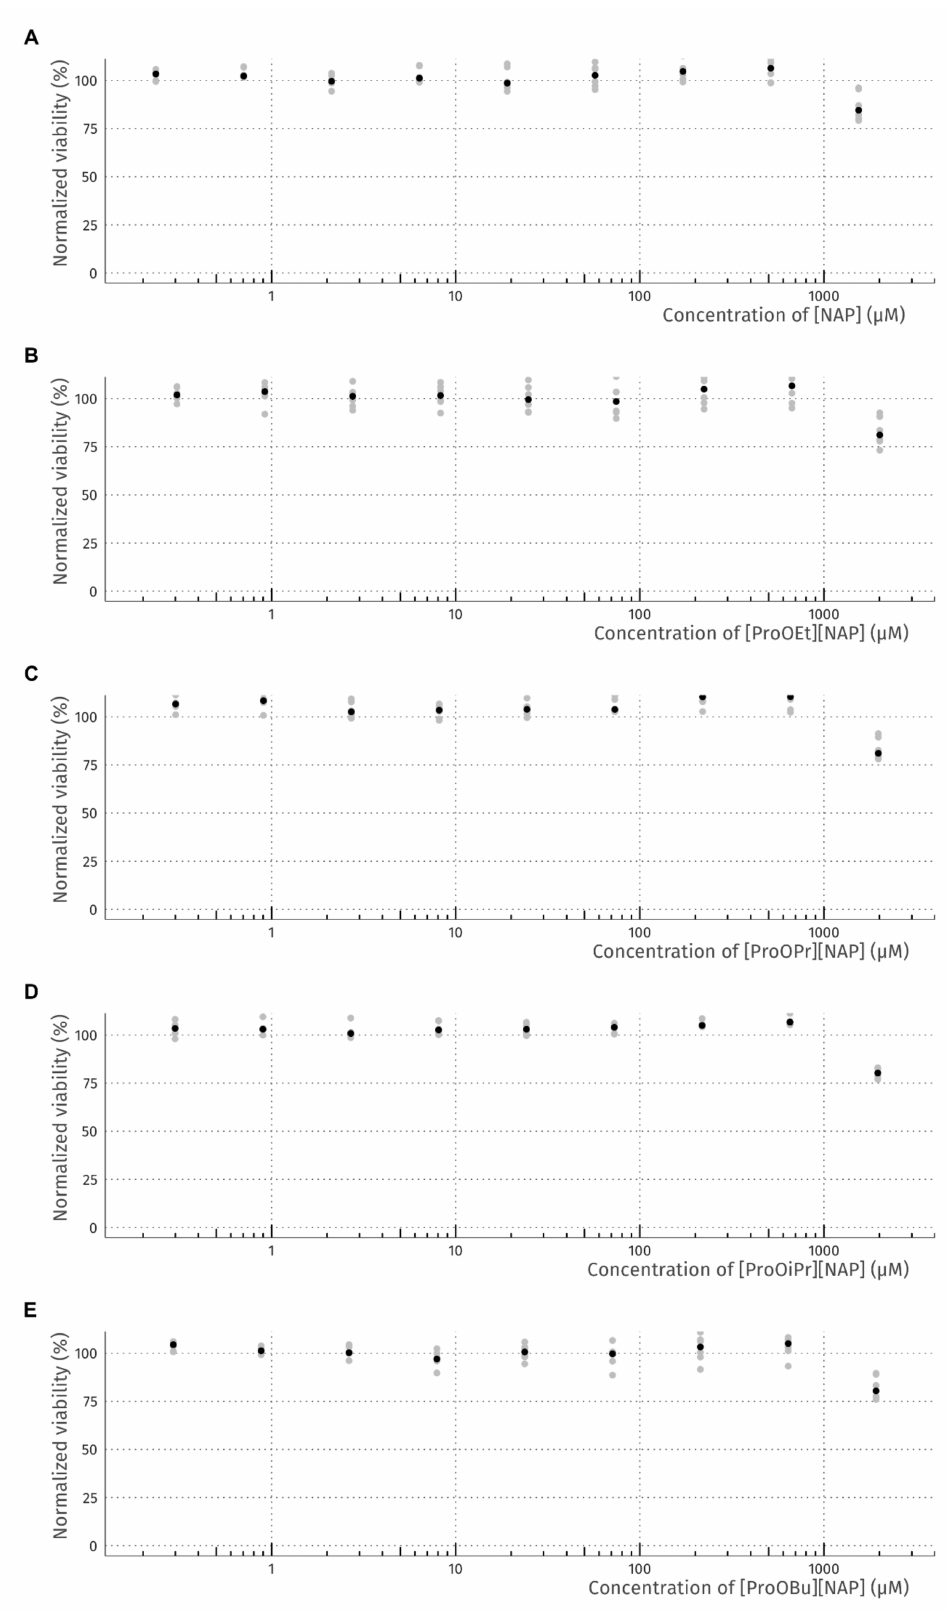
Figure 14. L929 cell viability (24 h exposure) as a function of dose for: ( A ) [NAP], ( B ) [ProOEt][NAP], ( C ) [ProOPr][NAP], ( D ) [ProOiPr][NAP], and ( E ) [ProOBu][NAP]. Gray dots represent technical replicates; black dots represent